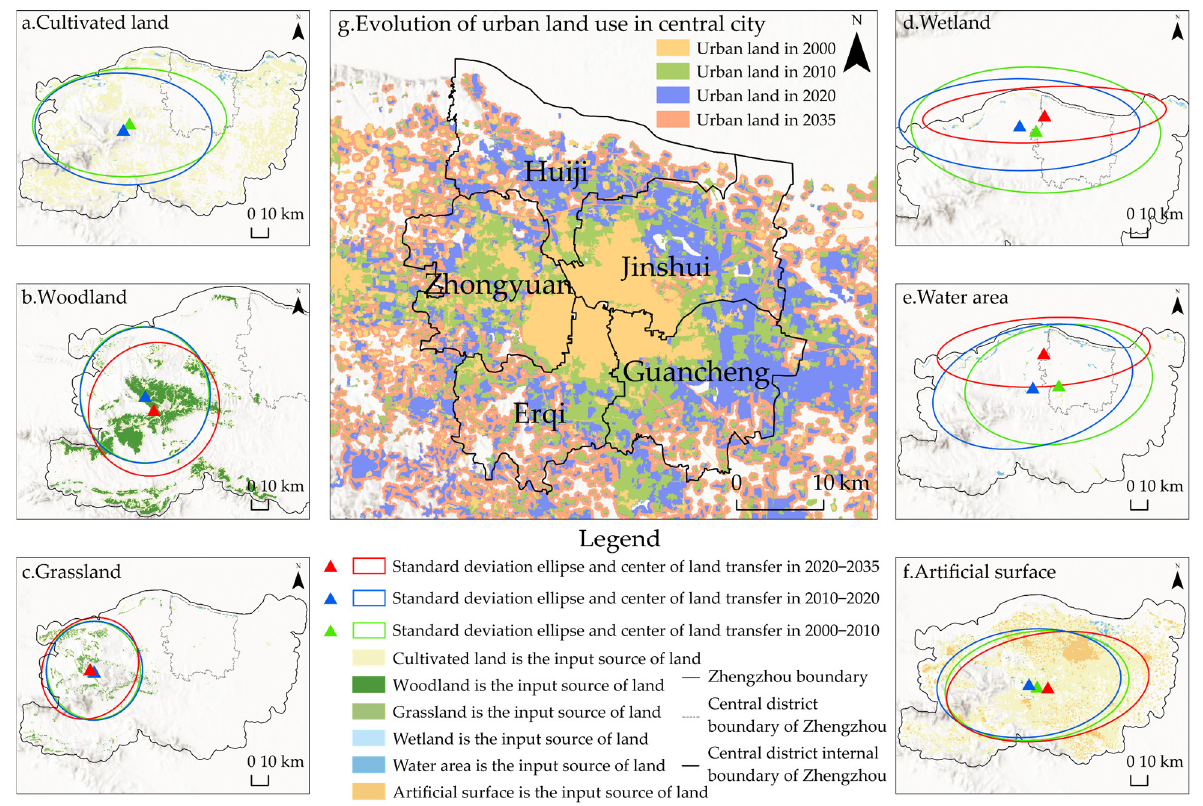
Figure 6. Changes in land use pattern from 2000 to 2035. Table 5. Land area and comprehensive index of land use from 2000 to 2035.